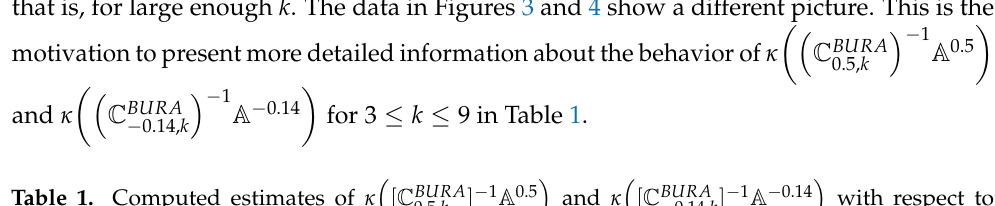
Figure 4. Theoretical estimates (24) vs. computed estimates (25) of κ respect to the BURA degree k , for δ = κ ( A )